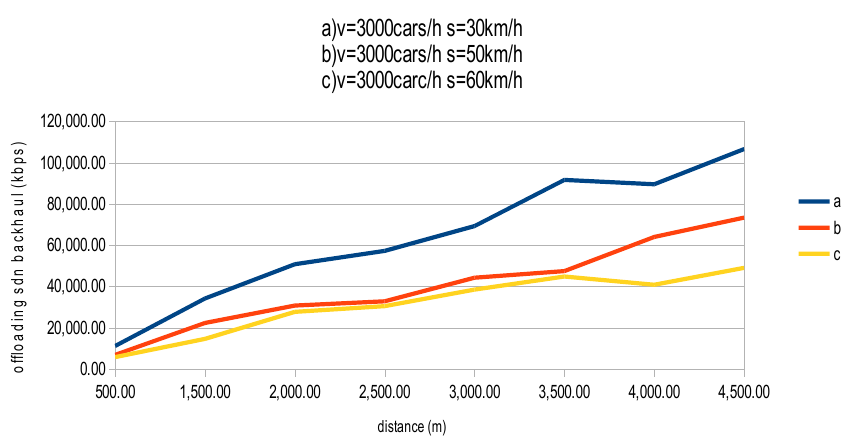
Figure 7. The rate of data offloaded to the backhaul network for scenario (B).